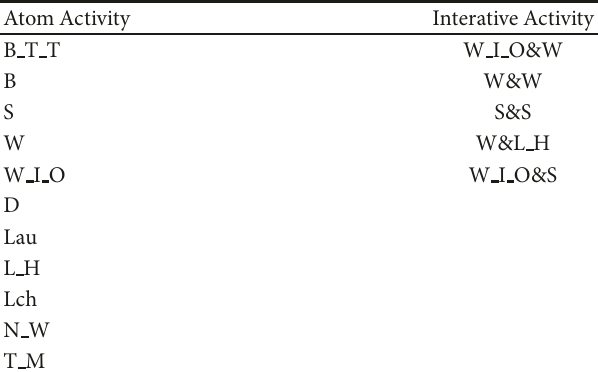
Table 3: Involved activities concerning on